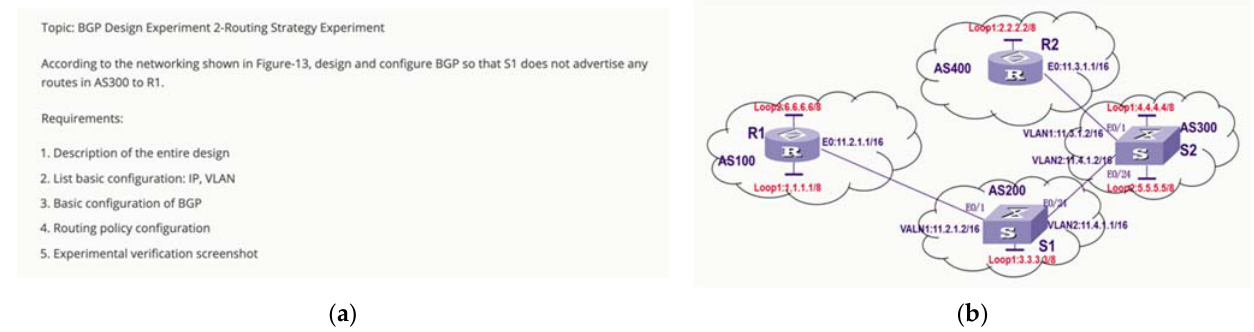
Figure 5. BGP design experiment: ( a ) describes the background and requirements of the assignment, and lists five questions that students need to answer; ( b ) shows the network topology of this assignment.